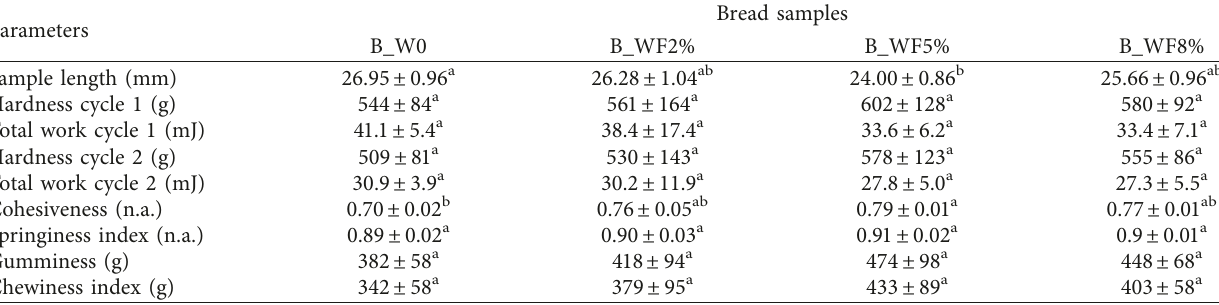
Table 3: Texture profile analyses for bread samples supplemented with fenugreek flour.